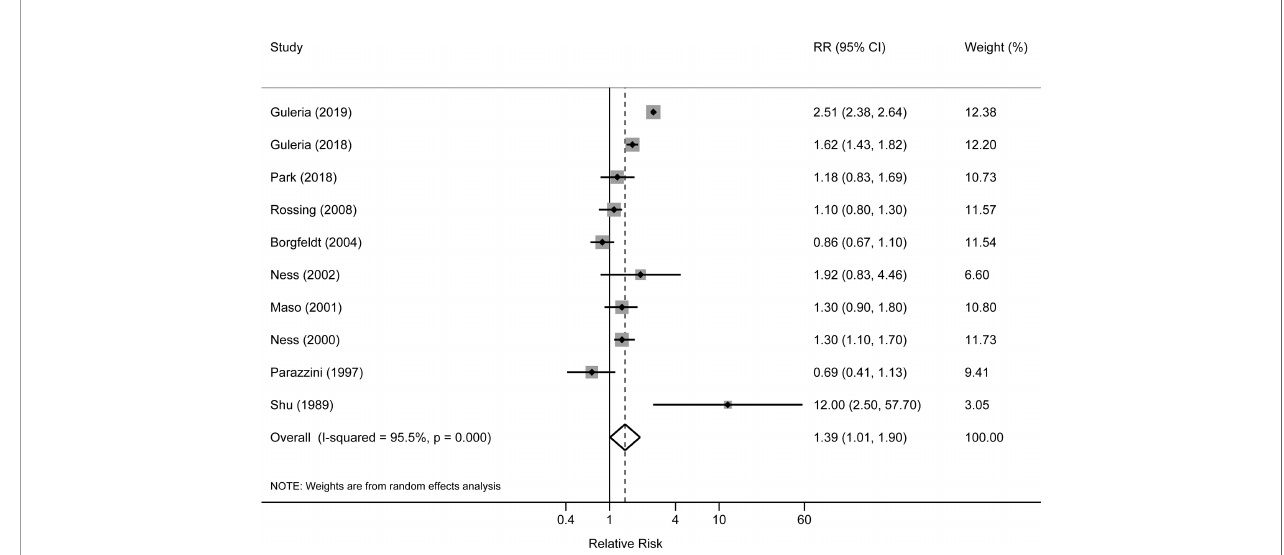
FIGURE 2 | Forest plot for the association between benign ovarian tumors and risk of ovarian cancer.